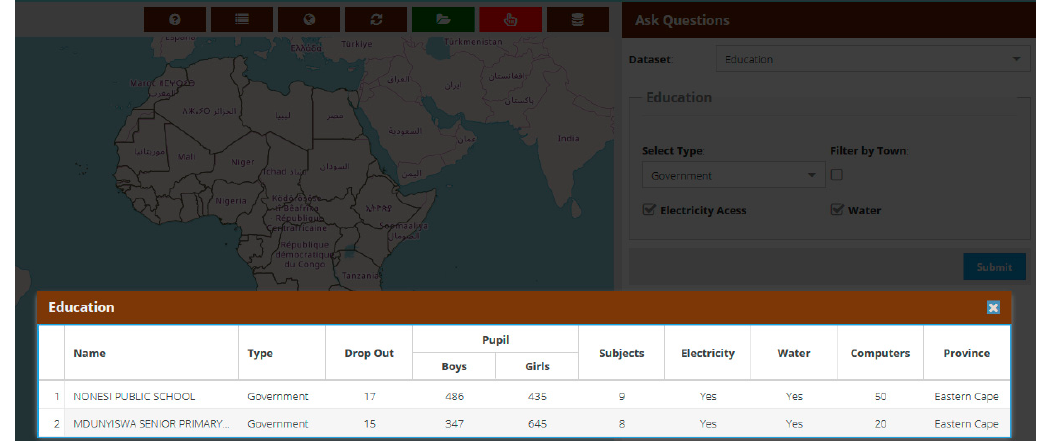
Figure 12. Education information queries displayed by the front end.